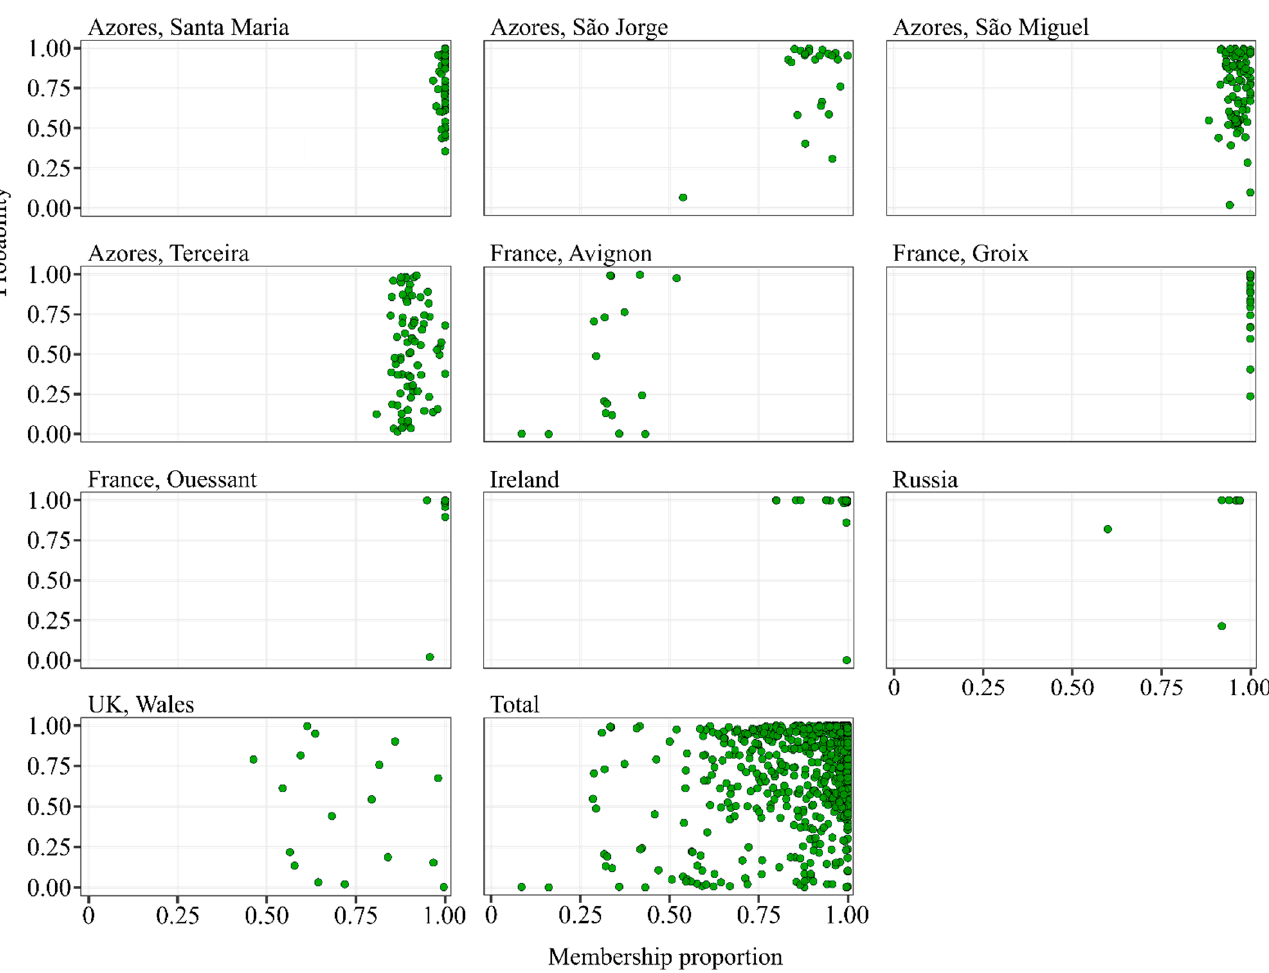
Figure 3. Scatter plots showing the probability of belonging to M lineage (Y-axis) vs. membership proportions in M lineage (X-axis) for individual datasets and for the whole dataset. Classification probabilities were inferred from wing images using the software DeepWings©, whereas membership proportions were inferred from microsatellites (Groix, Ireland and Russia) or SNPs (Portugal, Spain, Azores, Avignon, Ouessant, and Wales) using the software Structure or Admixture, respectively. Each dot represents a colony.